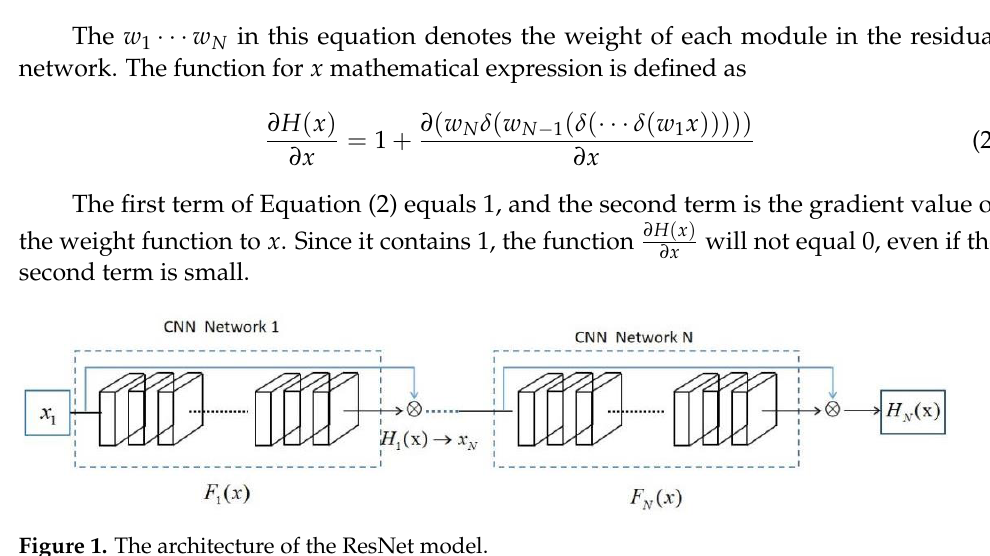
Figure 1. The architecture of the ResNet model.